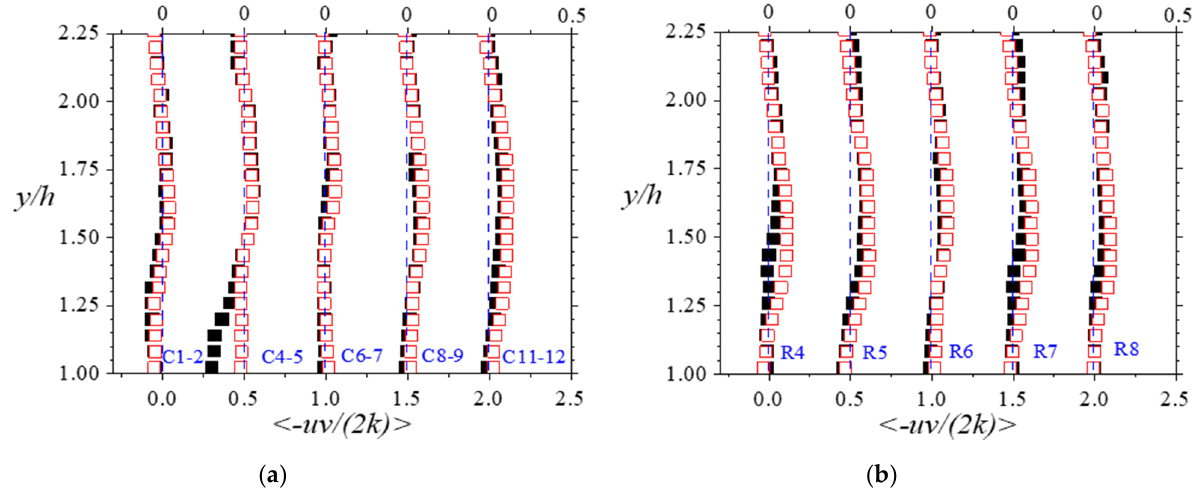
Figure 19. Evaluation of Townsend structure parameter for the flow in the open region is shown. Staggered plots ( a ) show the streamwise variations whereas staggered plots ( b ) demonstrate the spanwise variations. The denominations C and R respectively stand for columns and rows, and are illustrated in Figure 1. Black-filled boxes are the results for Test A , and red-open boxes are the results for Test B .